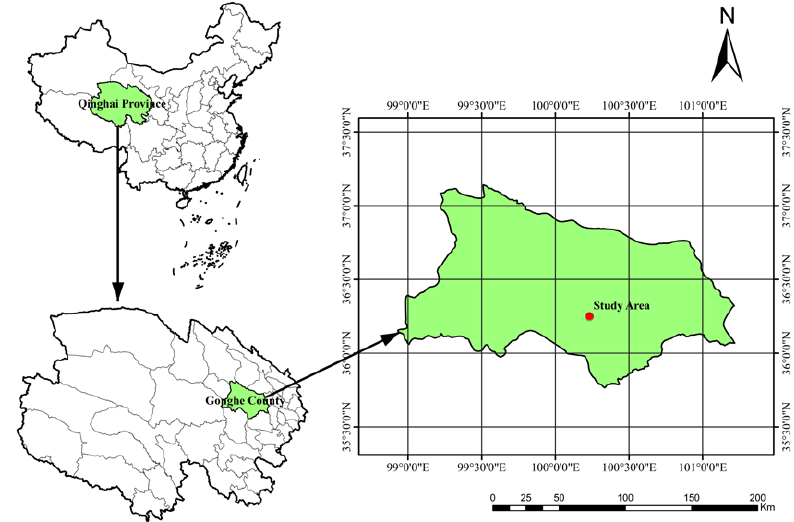
Figure 1. Location of the study area, Gonghe County, Qinghai Province,